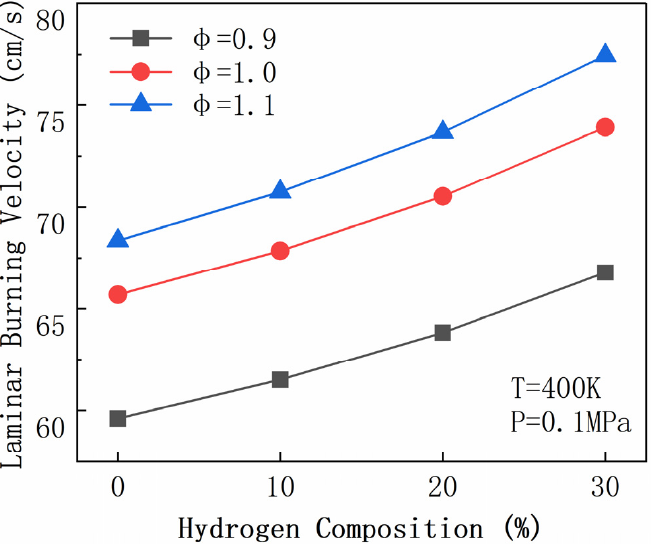
Figure 6. LBVs at different ER as a function of hydrogen composition (T0 = 400 K, P0 = 0.1 MPa).